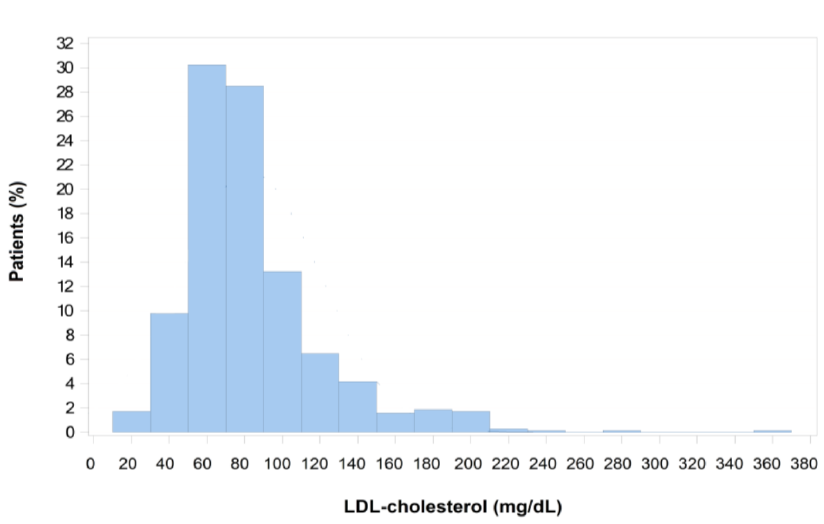
Figure 1. LDL-cholesterol at